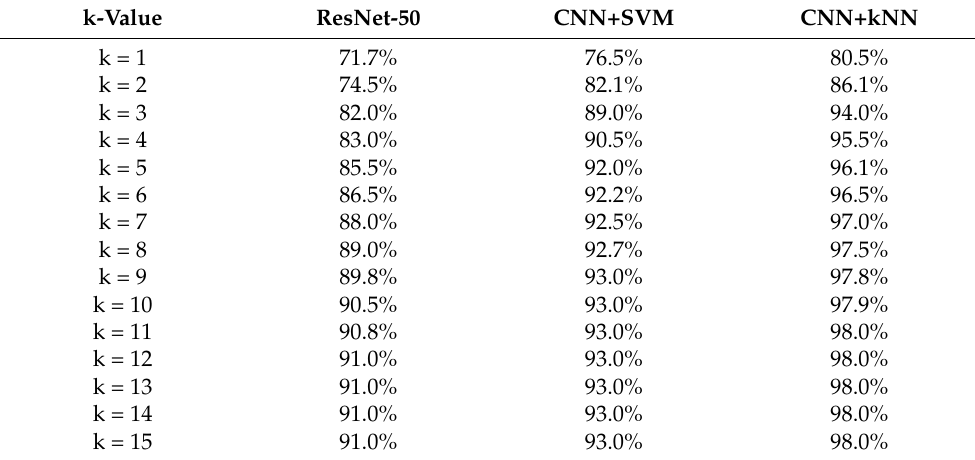
Table 4. Top-k Accuracy Comparison